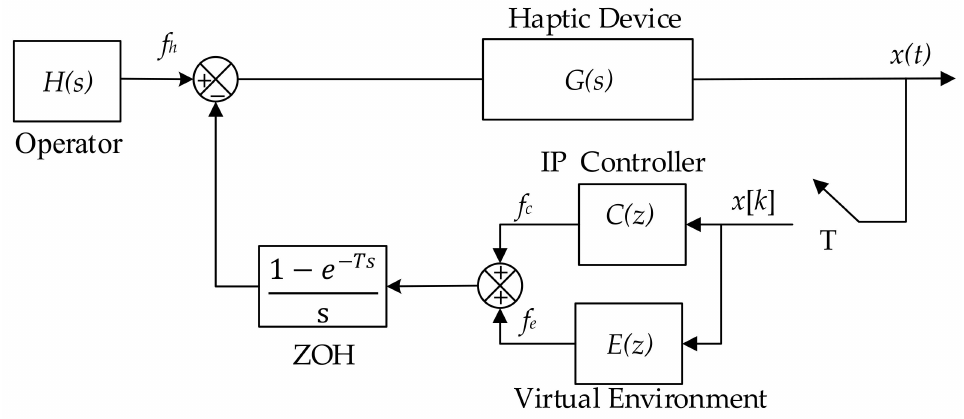
Figure 1. Framework of the impedance-passivity